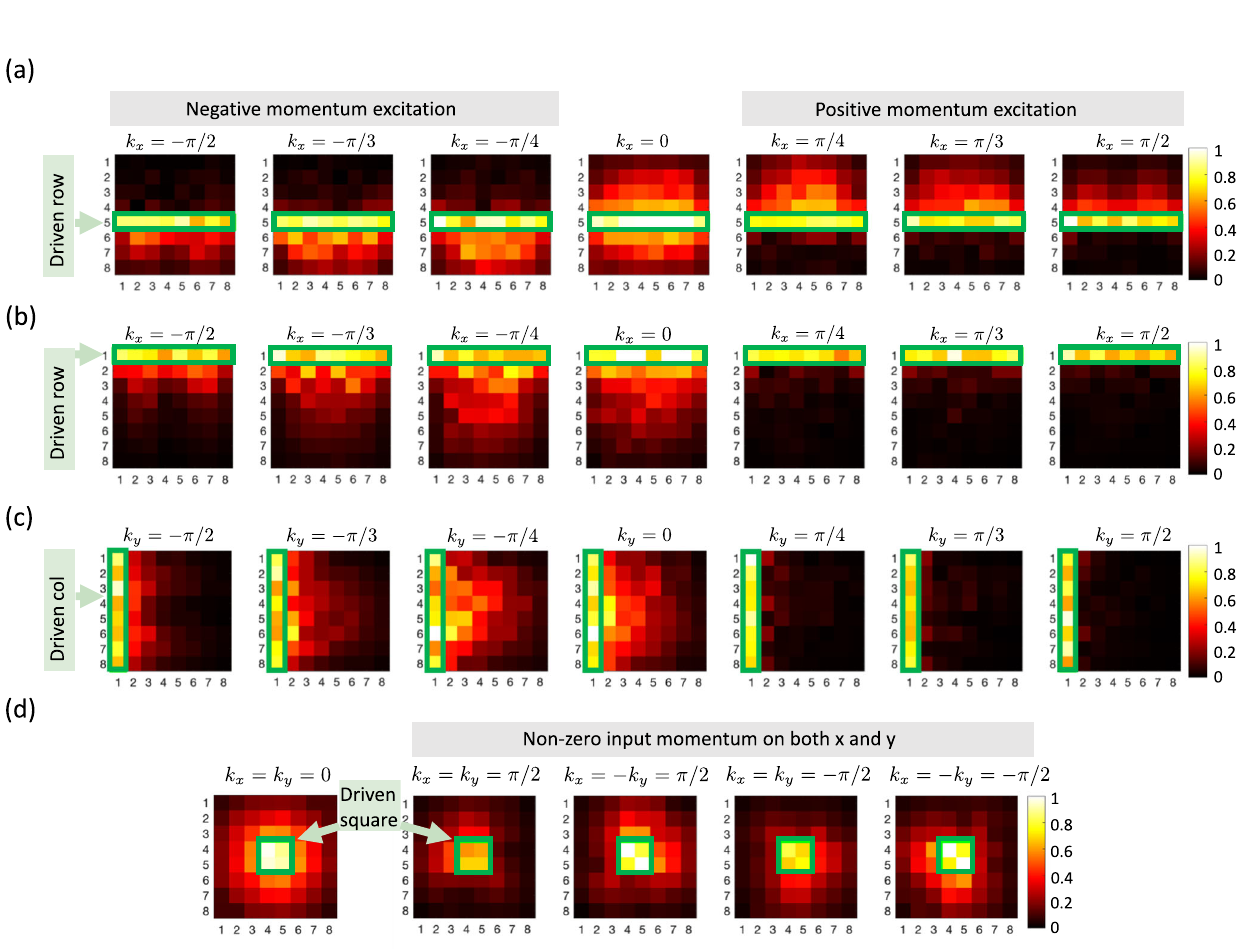
Fig. 5 | Responsestoinputexcitationsforthesquaregeometry. The magnitude ofvoltageresponsestodifferent k x inputon( a )the fi fthrowand( b )the fi rstroware presented. c Similarly shows the magnitude of voltage responses to different k y input on the fi rst column. d The magnitude of voltage responses to simultaneous